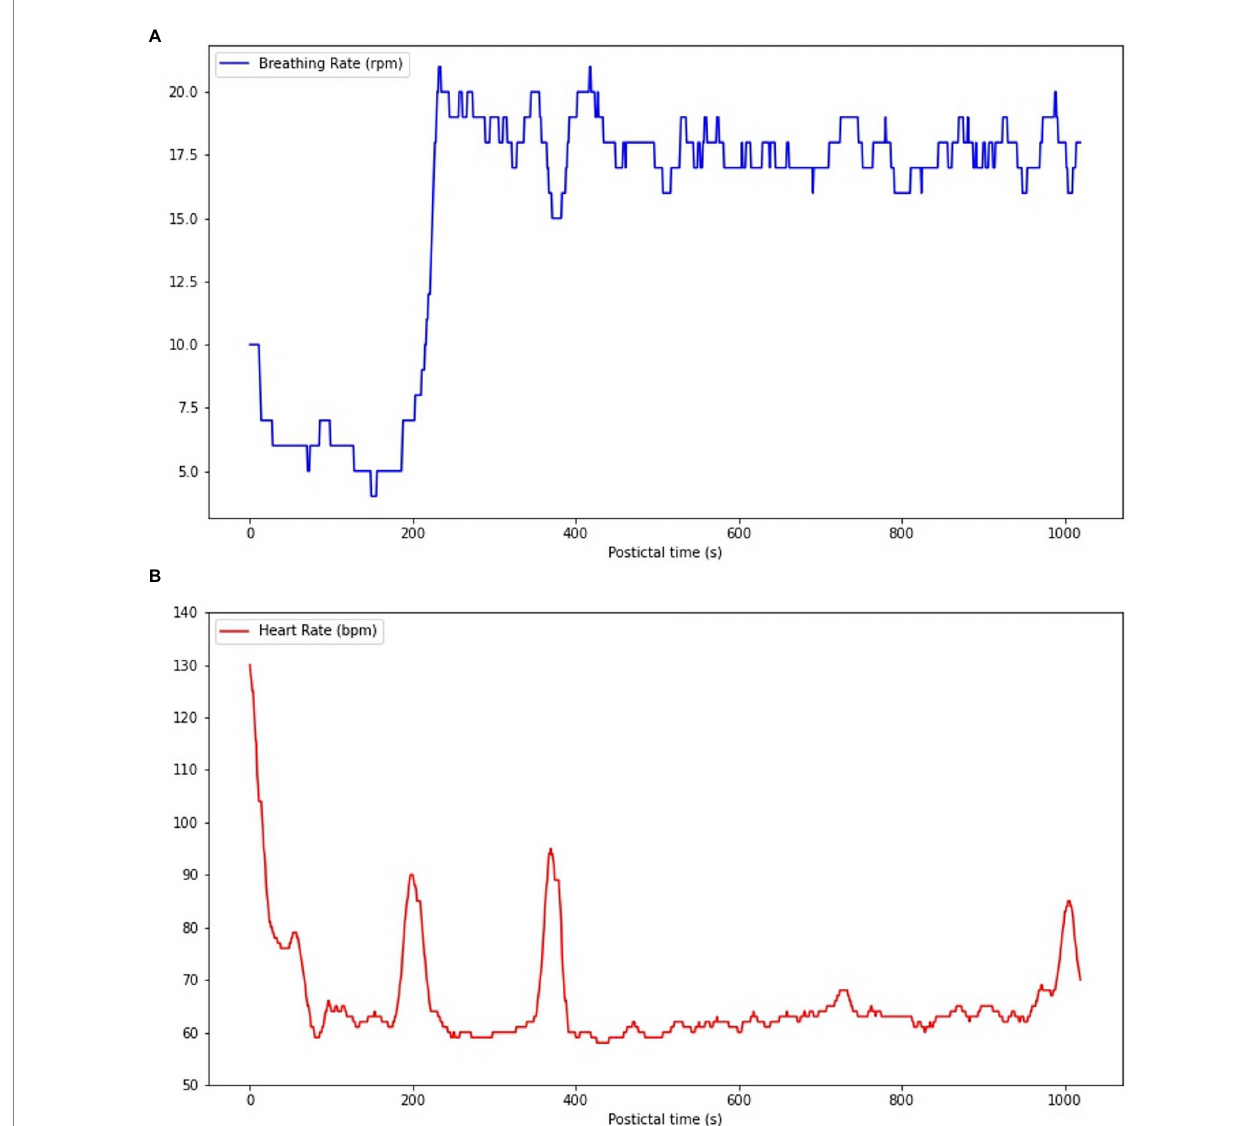
FIGURE 3 Cardiorespiratory functions during the postictal phase following one of the SUDEP patient’s FIAS. (A) A hypopnea (mean BR = 9.9 rpm) immediately follows seizure termination for 12 s, with BR decreasing to 4 rpm. (B) A tachycardia (mean HR = 116 bpm) is present following seizure termination for 15 s, but HR rapidly decreases to 59 bpm, resulting in a bradycardia for 10s (mean HR = 59.4